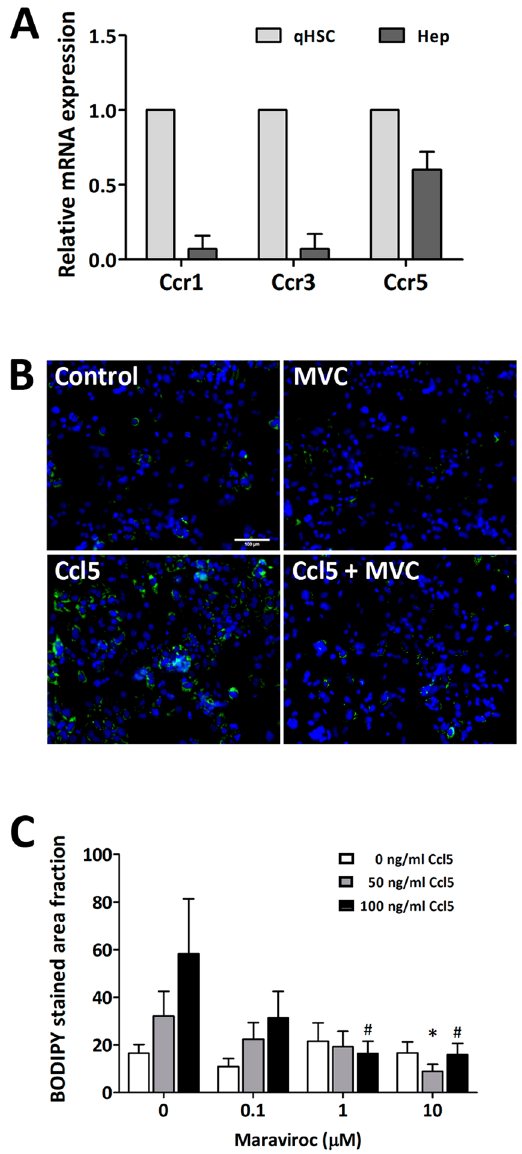
Figure 5. Ccr5 specific inhibitor Maraviroc attenuates pro-steatotic effect of Ccl5 on hepatocytes. ( A ) Primary hepatocytes express Ccr5 at a level significantly higher than Ccr1 or Ccr3, measured with qPCR. ( B , C ) Ccr5 specific inhibitor Maraviroc attenuated pro-steatotic effect of Ccl5 on primary hepatocytes, the level of steatosis quantified with Bodipy stained area fraction. Data are presented as mean + / − SD ( * P < 0.05 for comparisons among cells receiving 50 ng/ml of Ccl5; # P < 0.05 for comparisons among cells receiving 100 ng/ml of Ccl5). qHSC, quiescent hepatic stellate cell; Hep, hepatocyte; MVC,